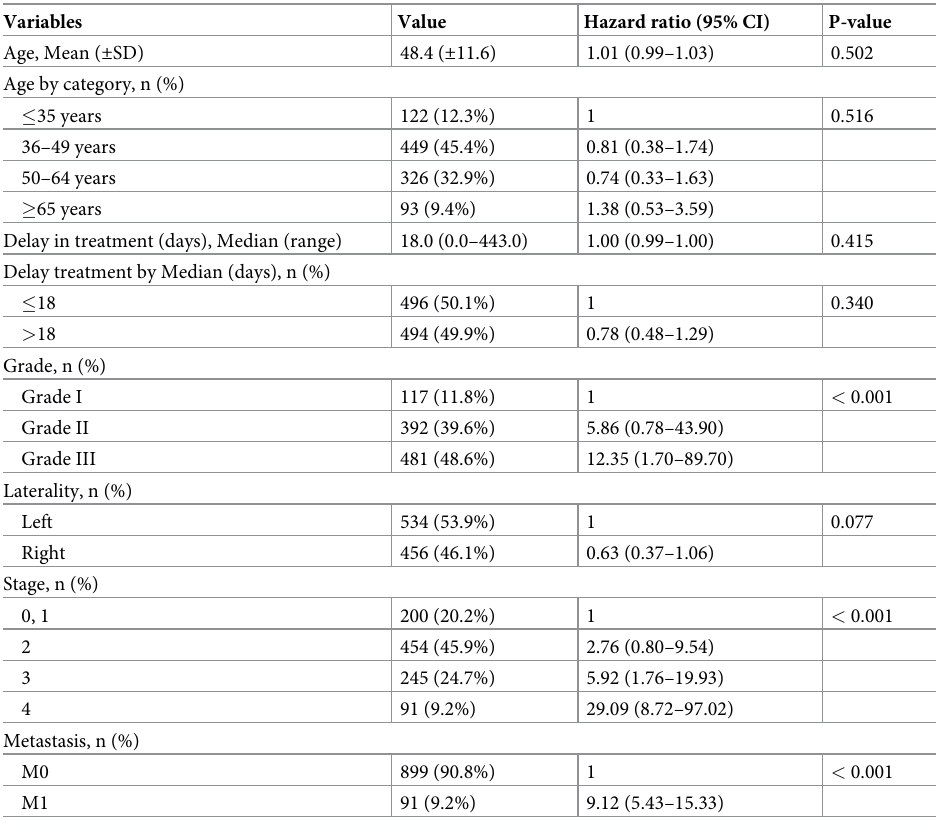
Table 2. Crude hazard ratio of overall survival associated with several prognostic